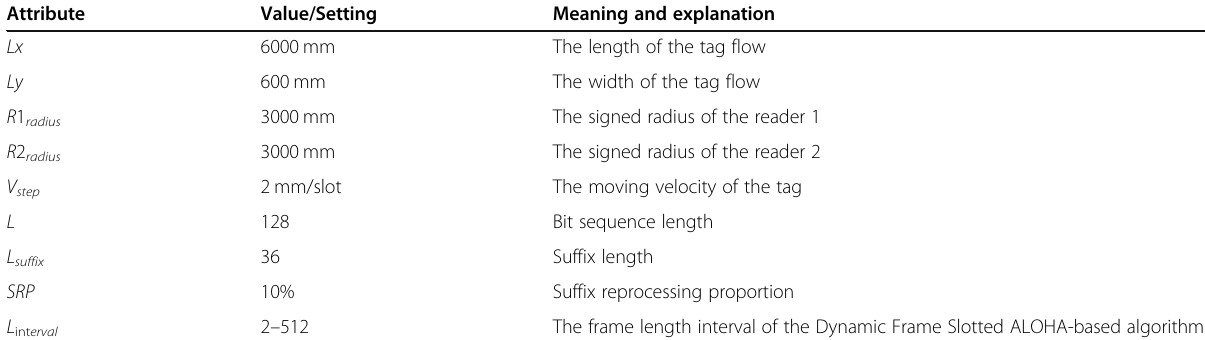
Table 3 Default attribute values used in the simulation